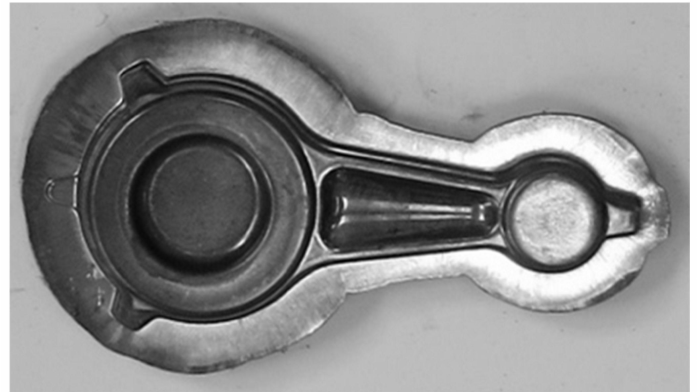
Figure 27. Forgings of connecting rods made of AB-71100 aluminum alloy obtained in the forging process on a crank press from cast preforms in accordance with variant